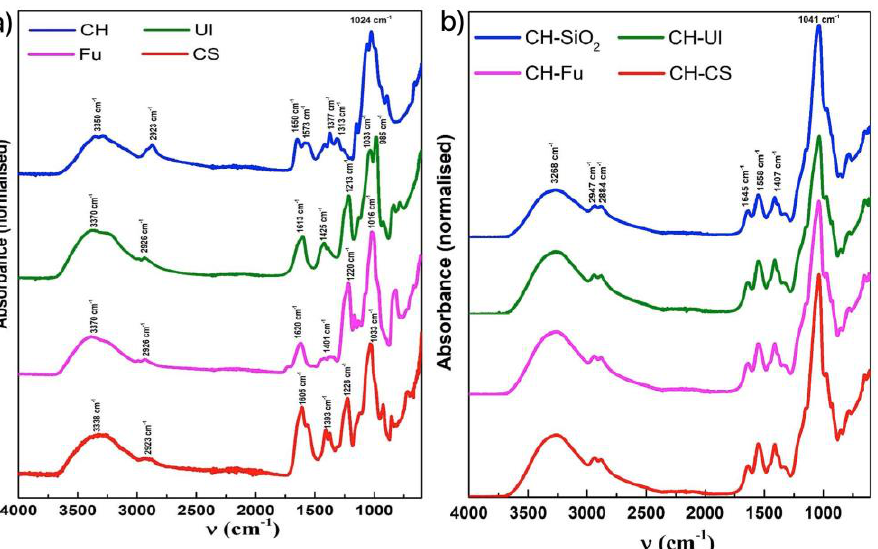
Figure 1. Graphical representation of ATR-FTIR spectra of: ( a ) different polysaccharides; ( b ) different types of membranes.